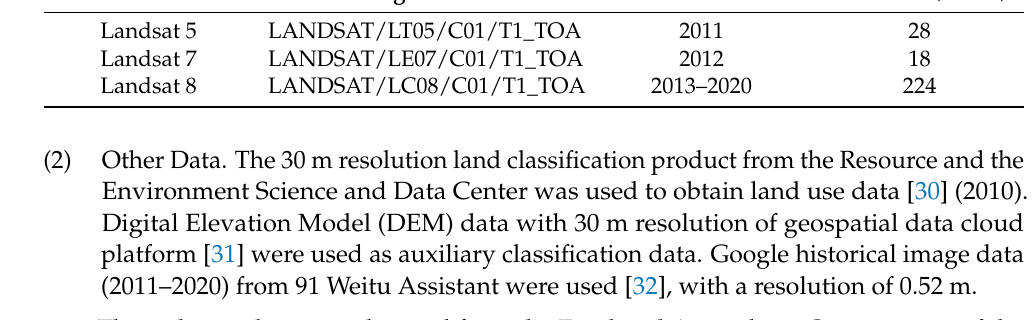
Table 1. Landsat image